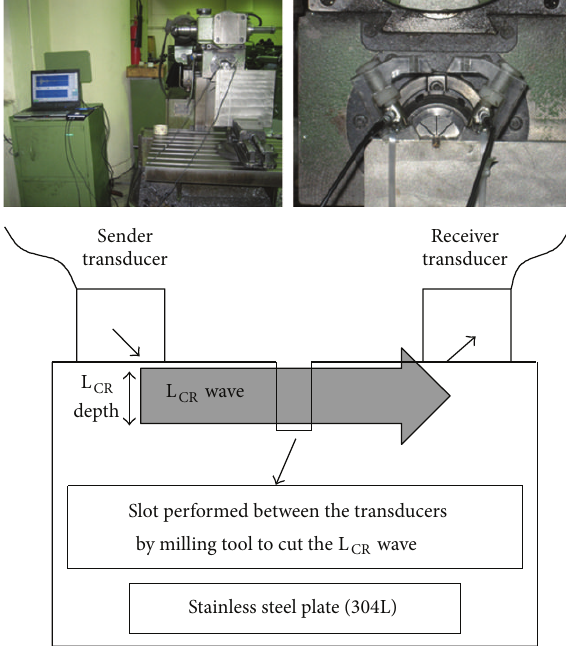
Figure 5: Experimental setup to measure depth of L CR